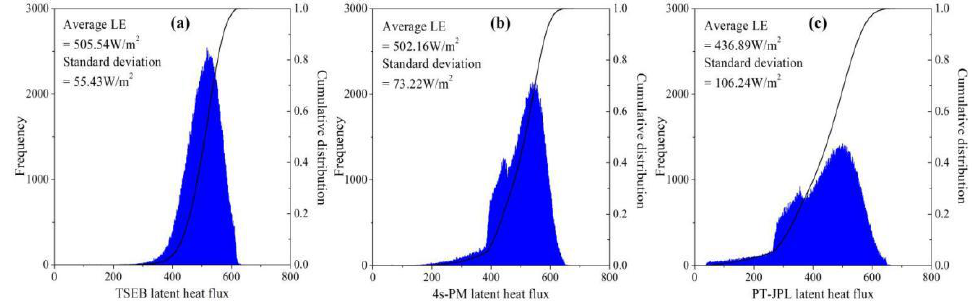
Figure 9. Histogram of the LE on 18 May of 2015 for different modes: ( a ) TSEB, ( b ) 4s-PM, and ( c ) PT-JPL.